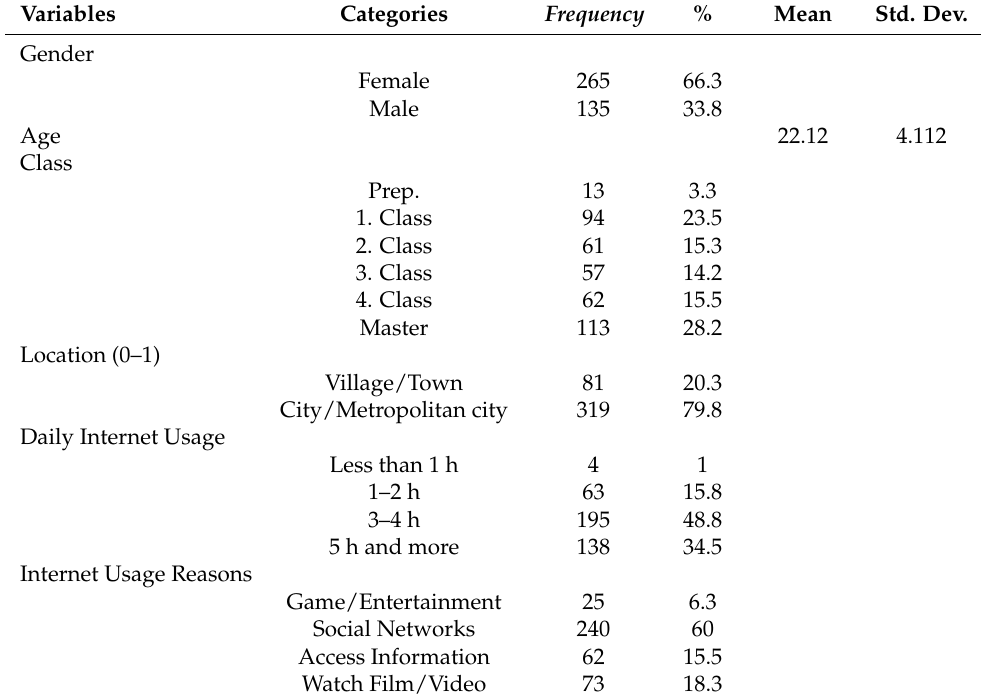
Table 1. Descriptive statistics.